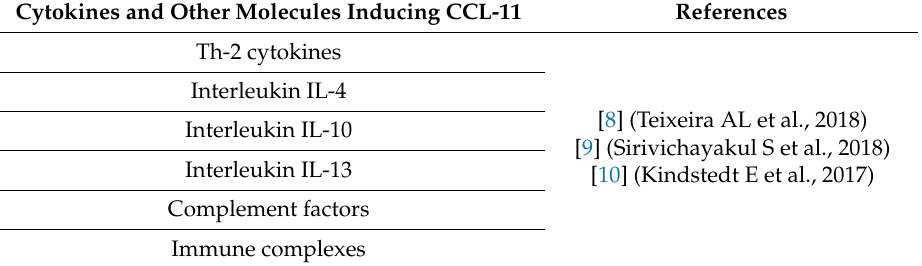
Table 2. Cytokines and other molecules inducing